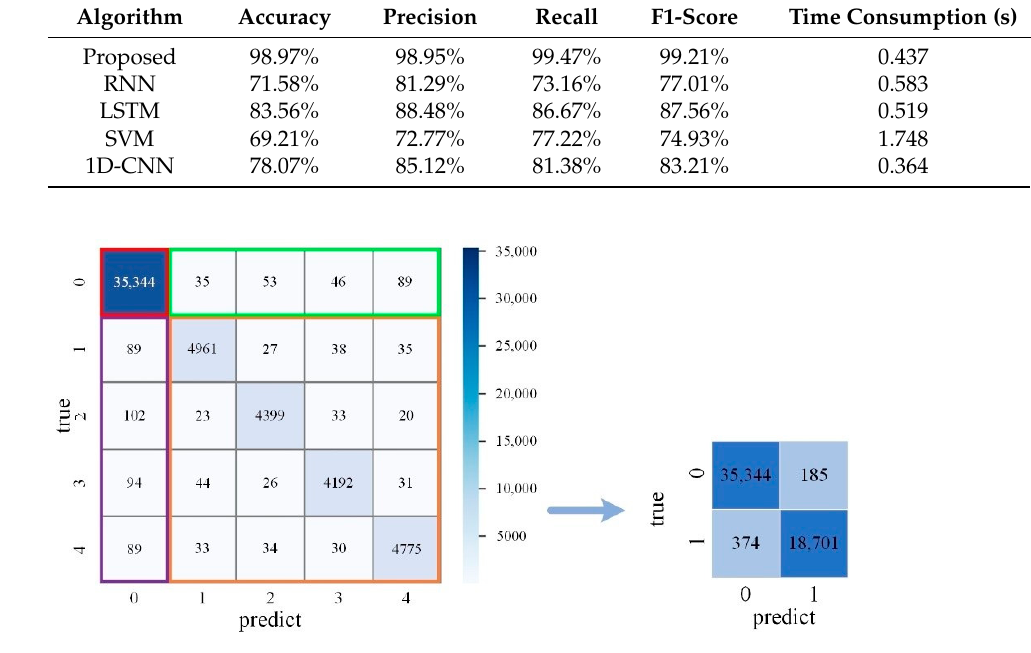
Figure 9. Confusion matrix of the proposed model, with 0 to 4 referring to normal and abnormal of states of the air compressor, cutting equipment, mixing equipment and stirring kettle, respectively.